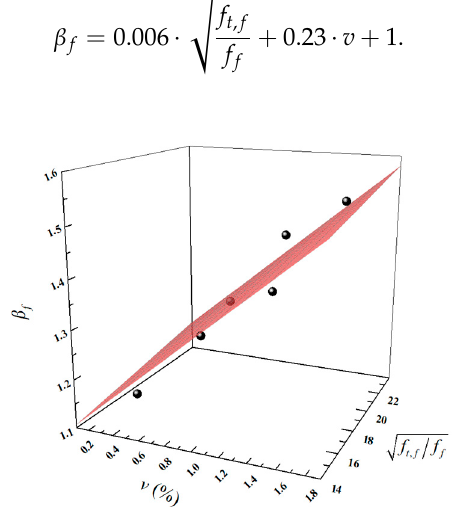
Figure 15. The fitting effect of β f . Table 7. Comparison of test and calculation results of β f.